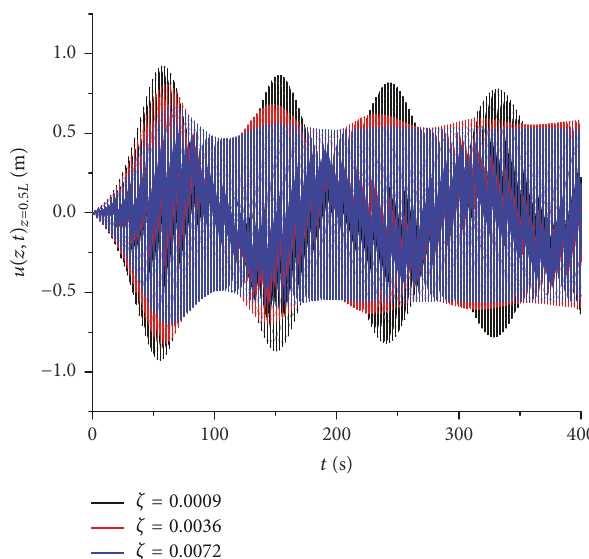
Figure 12: The effect of damping ratio on the dynamic response of the cable ( 𝜔 V = 𝜔 1 and 𝜔 𝑝 = 2𝜔 1